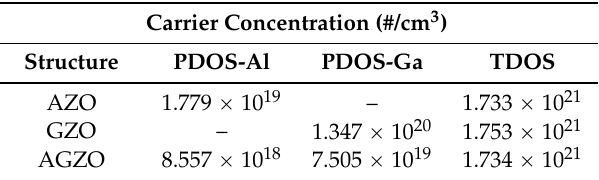
Figure 4. DOS of ( a ) AZO; ( b ) GZO; and ( c ) AGZO. Table 3. Calculated carrier concentration for Al/Ga ‐ doped ZnO.